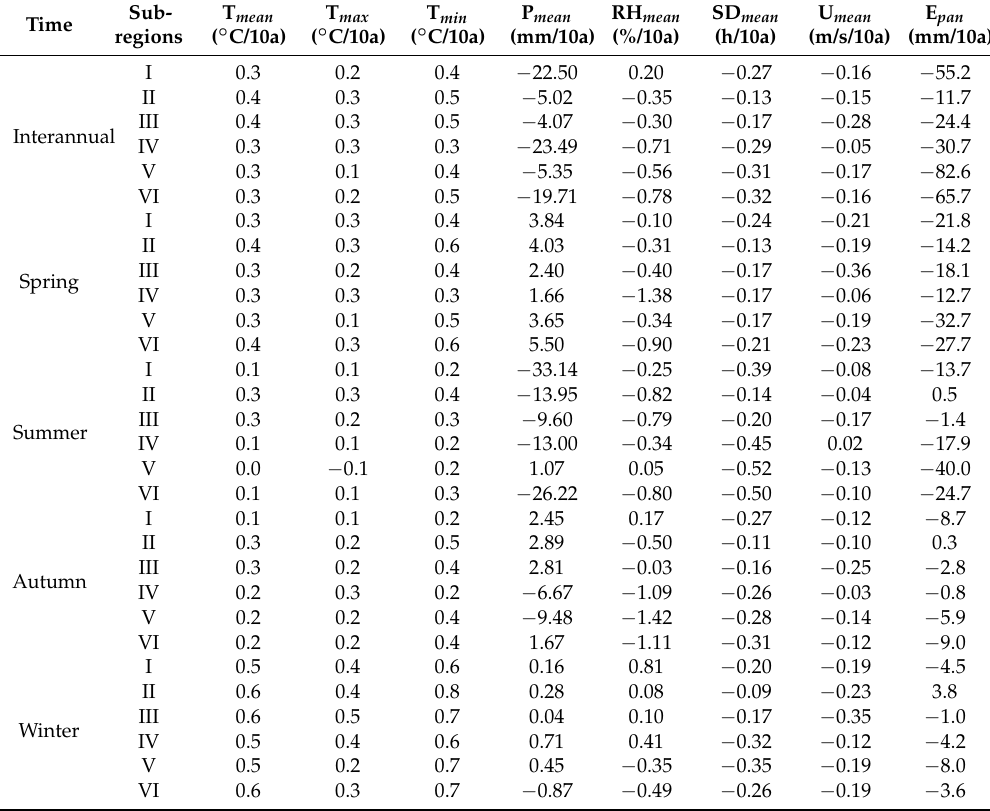
Table 4. Climate tendency rates of the meteorological elements per sub-region from 1961 to